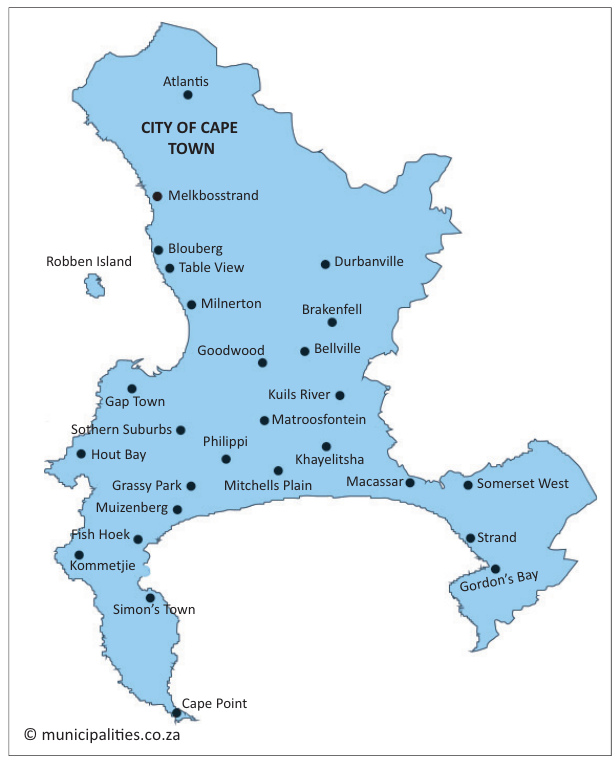
FIGURE 1: Cape Town Metropolitan